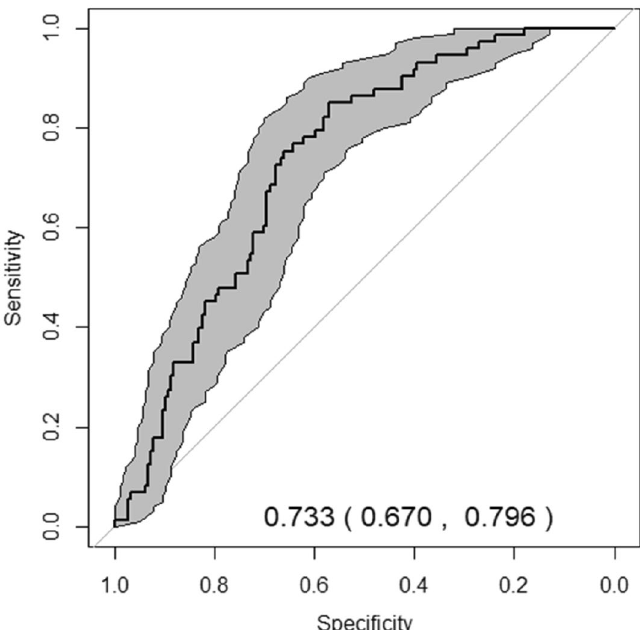
Figure 4. Area under the curve applied to the validation